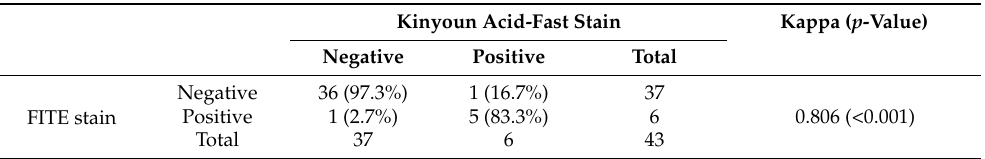
Table 2. Concordance in positivity of results between Kinyoun acid-fast and FITE stains performed on lung tissue sections (43 patients).